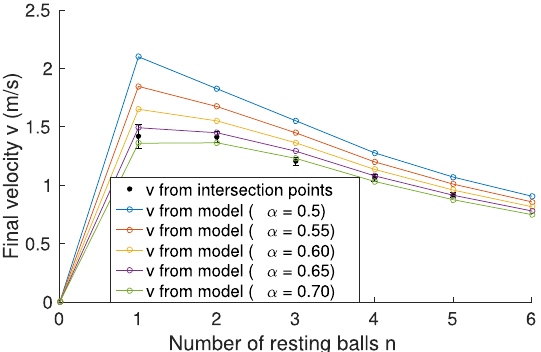
Fig. 9. Comparison between intersection points from linear regressions (yellow line in Fig. 7), and intersection points from our model ( fi x points from Eq. (4)). Since equation (4) depends on a , which is not yet known, several plots are made depending on the choice of a